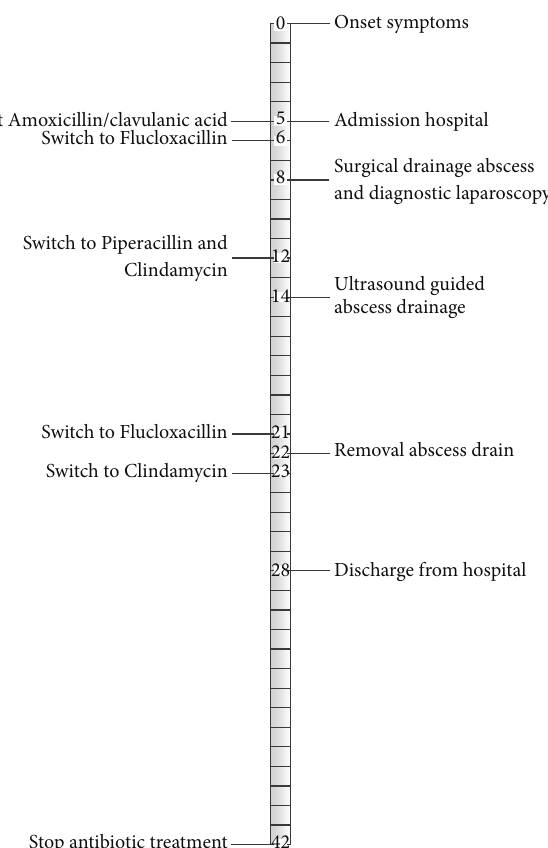
Figure 2: Timeline on clinical course; numbers indicate days after onset of